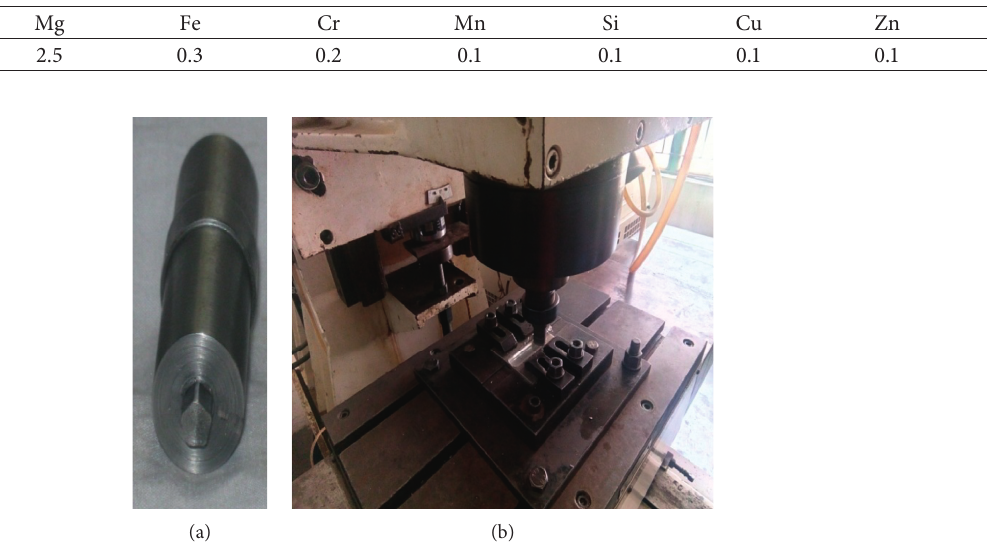
Figure 1: (a) Pentagonal tool pin profile and (b) friction stir processing.